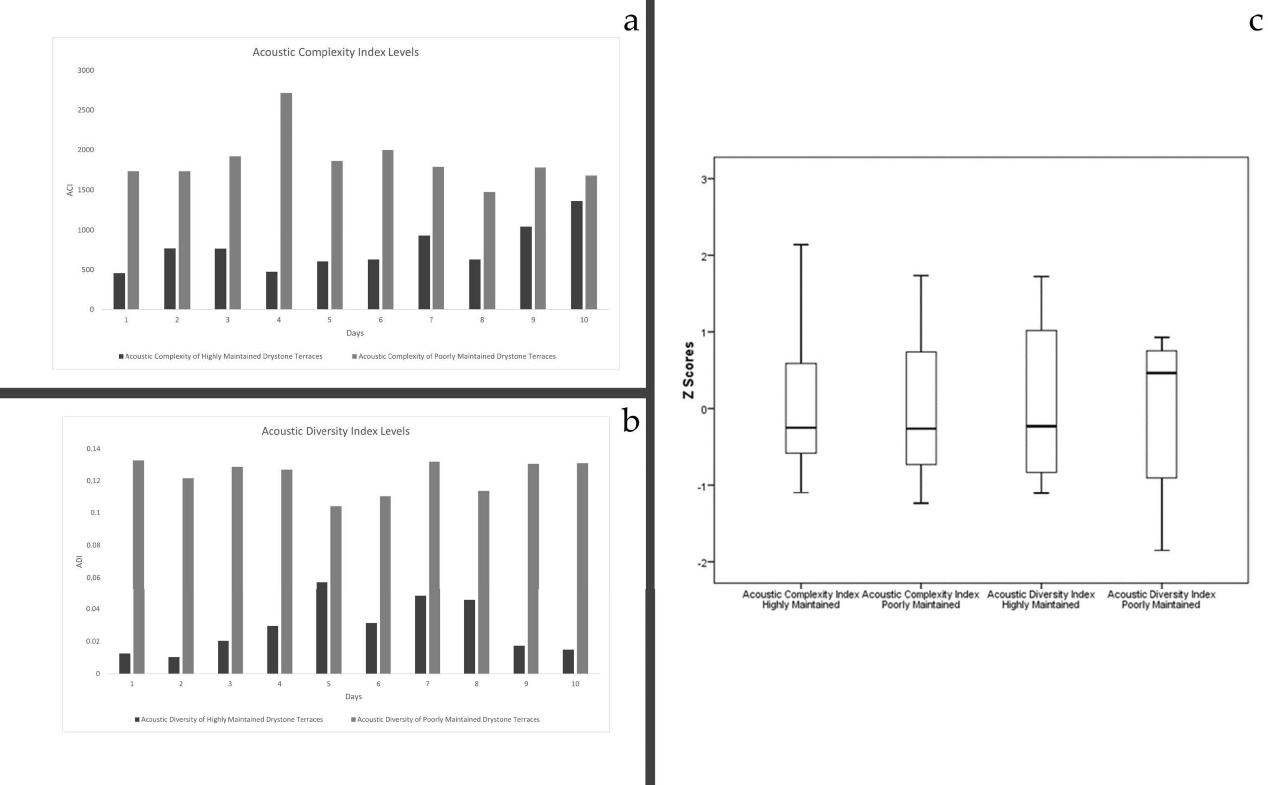
Figure 2. Top left ( a ) The resulting acoustic complexity index levels for each day of measurement for the highly and poorly maintained drystone terraces, bottom left. ( b ) The resulting acoustic diversity index levels for each day of measurement for the highly and poorly maintained drystone terraces, on the right. ( c ) The box plot of the acoustic indicators Z-scores in relation to different conditions of drystone terraces. The boxes represent the upper and lower quartile ranges and the